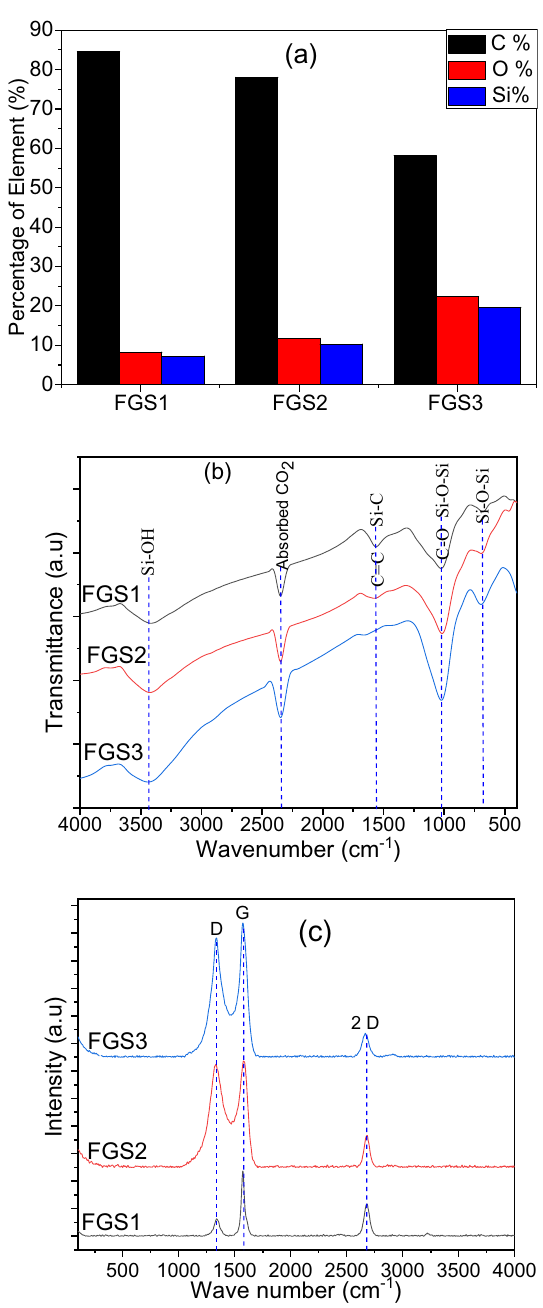
Figure 6. ( a ) Chemical composition, ( b ) FTIR, and ( c ) Raman of GO/SiO 2 nanocomposite